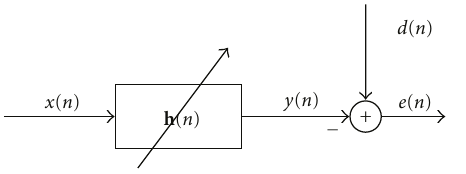
Figure 1: Prototypical adaptive filter